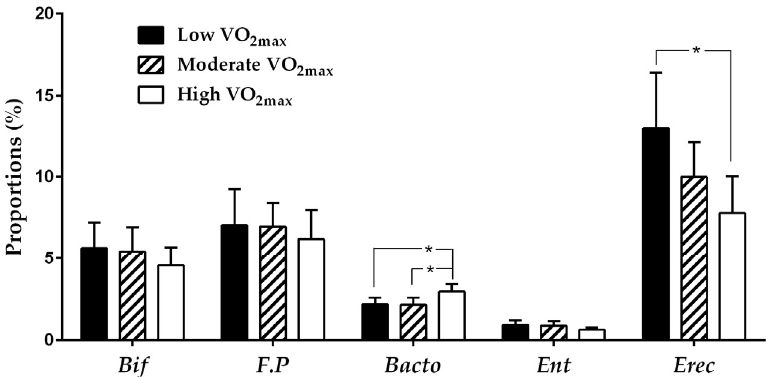
Figure 1. The microbiota composition in different fitness groups. The error bars represent mean and standard deviation. The contrast estimates ( p -values) by multivariable comparison with Sidak to localize the significant differences between the groups. * means p < 0.05. Bif = Bifidobacterium , F.p = Faecalibacterim prausnitzii , Bacto = Bacteroides , Ent = Enterobacteria , EreC = Eubacterium rectale ‐ Clostridium coccoides .